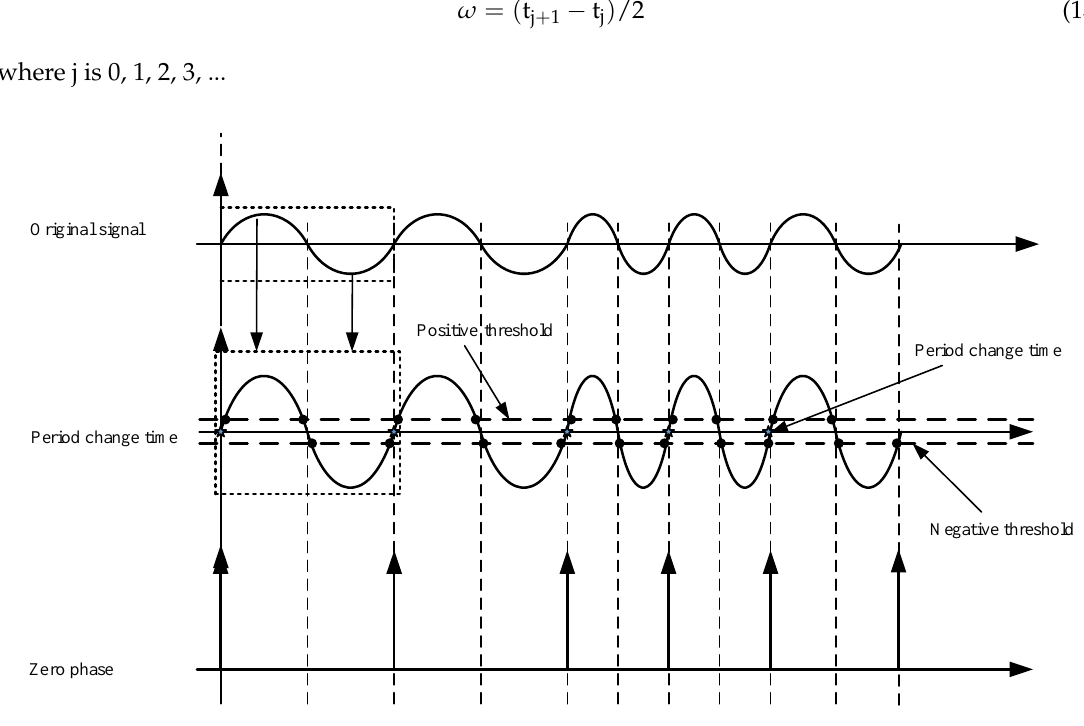
Figure 4. Conversion process of the coil sensor zero phase signal.